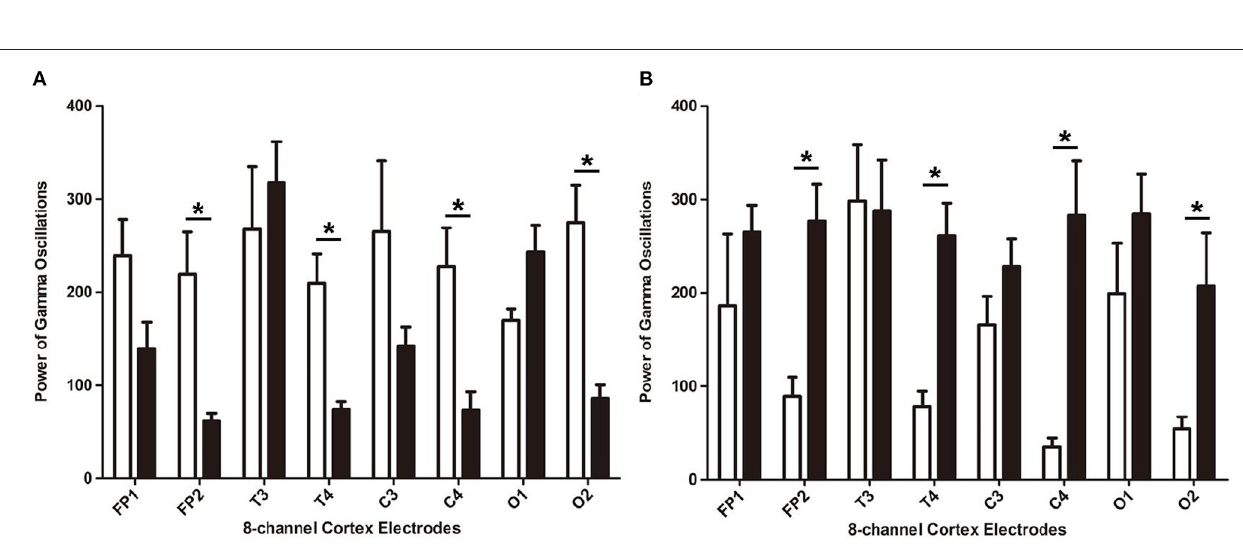
FIGURE 3 | The power of gamma oscillations of right-side TBI group in different electrodes. (A) Power of gamma oscillations of rat before and after TBI. The white bar represents the control group (a), and the black bar represents TBI (R, 7d) group. (B) Power of gamma oscillations of TBI with and without treatment of 40hz Blue LED. The white bar represents TBI (R, 7d), and the black bar represents TBI (R) + 40hz light (7d). P -values correspond to one-way ANOVA. Data are expressed as mean ± SEM. * P <